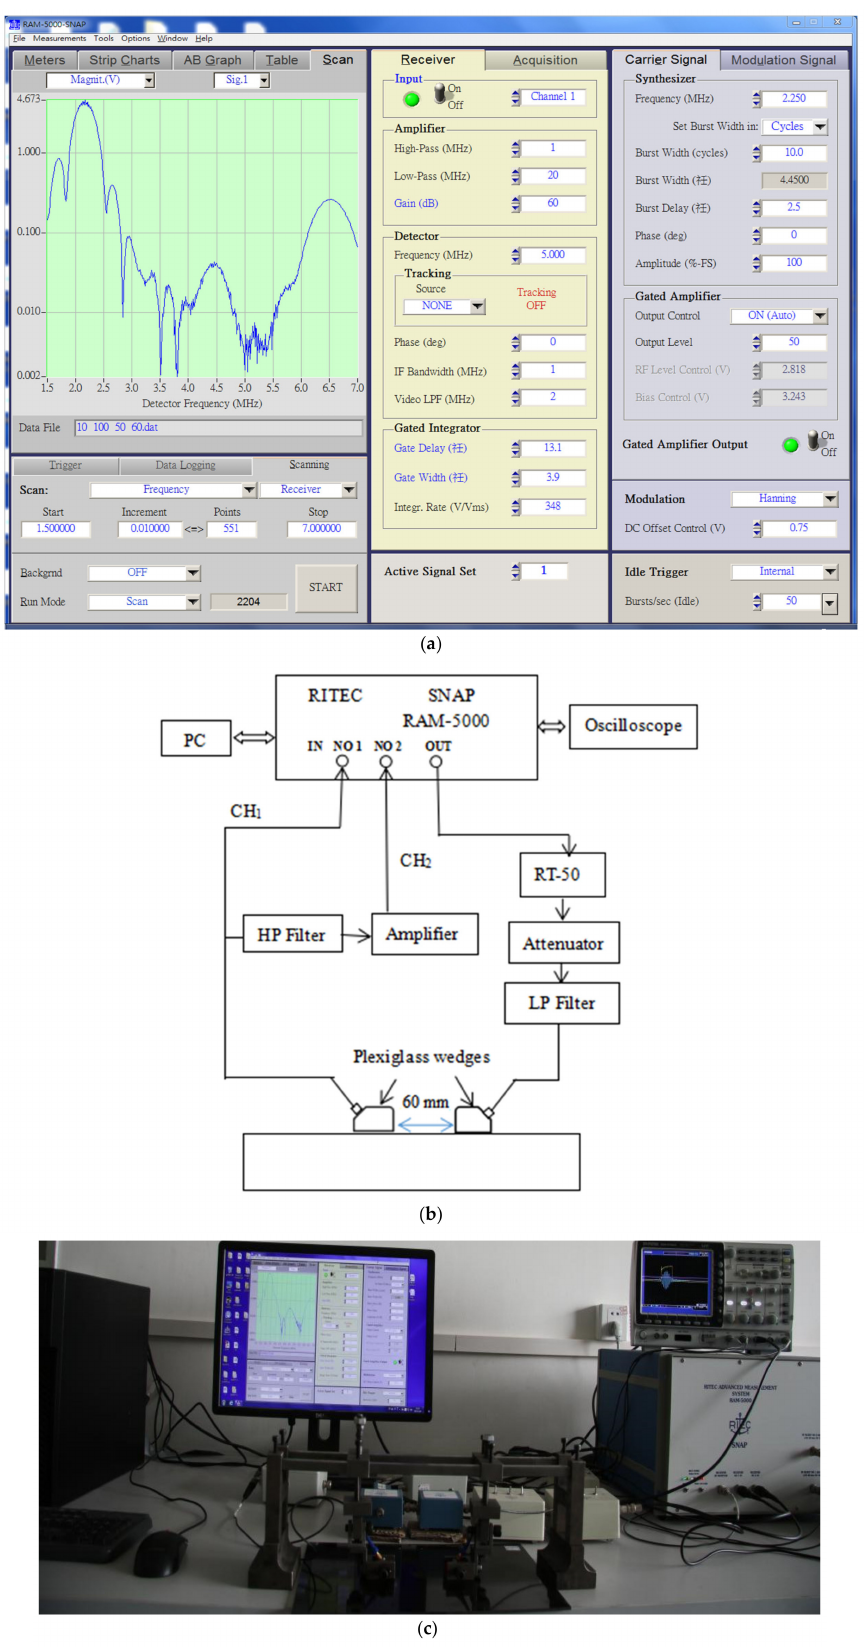
Figure 2. Nonlinear ultrasonic detection system: ( a ) Computer-controlled RAM-5000 SNAP ultrasonic detection system parameter settings, ( b ) block diagram of the experimental system setup, and ( c ) photograph of the experimental